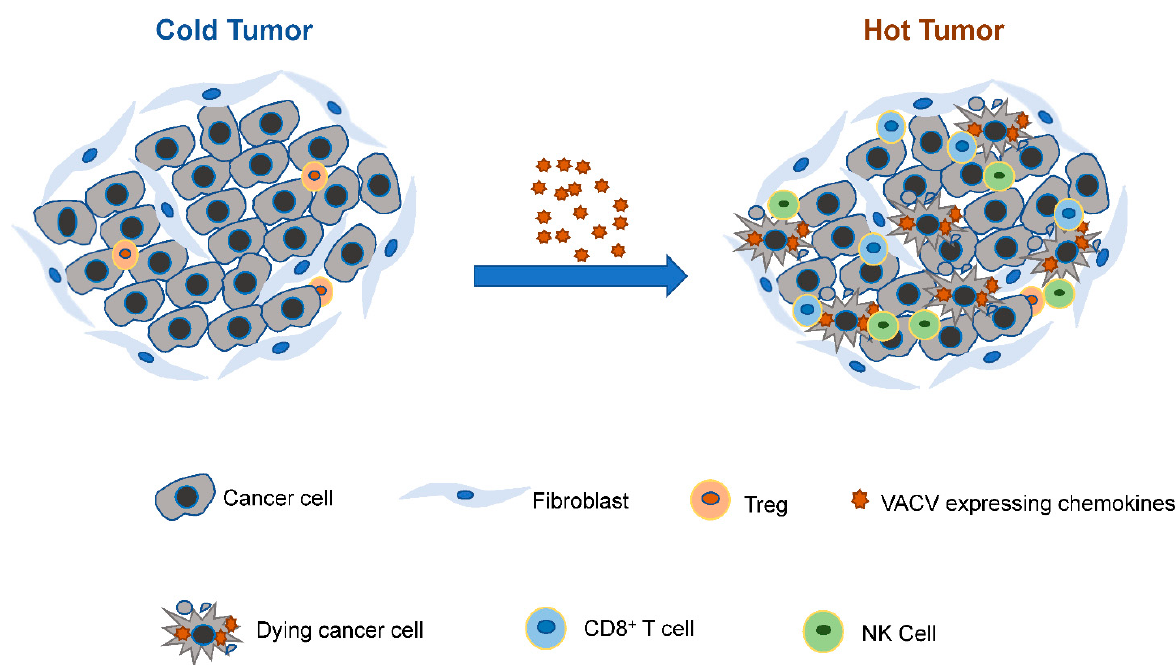
Figure 1. VACV infection might turn the cold tumor into a hot tumor. Recombinant chemokine- expressing VACV infects and kills tumor cells. At the same time, chemokines will be produced, and CD8 + T cells and NK cells will be recruited into the tumor, turning the cold tumor into a hot tumor to achieve better therapeutic antitumor efficacy. VACV combined with chemokine therapy may also achieve therapeutic antitumor efficacy.